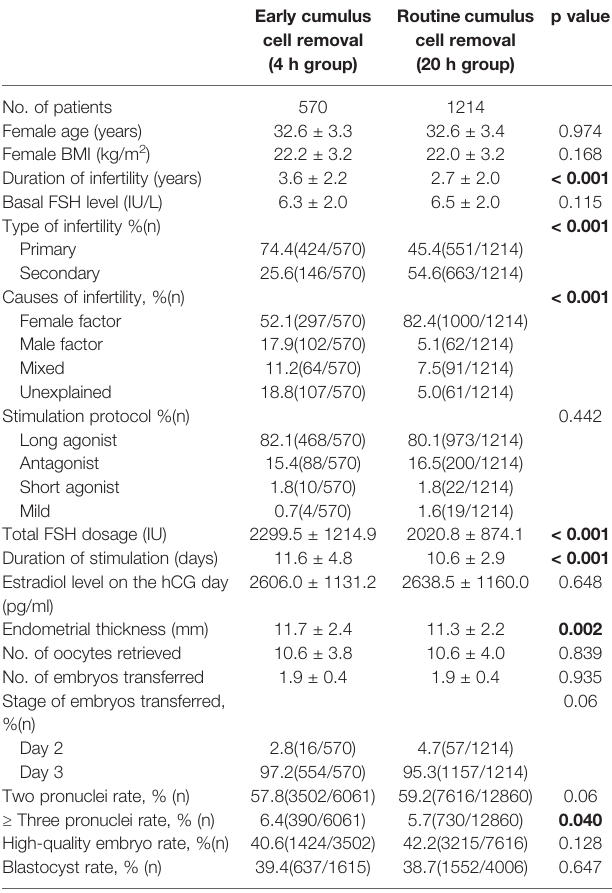
TABLE 1 | Demographic characteristics of